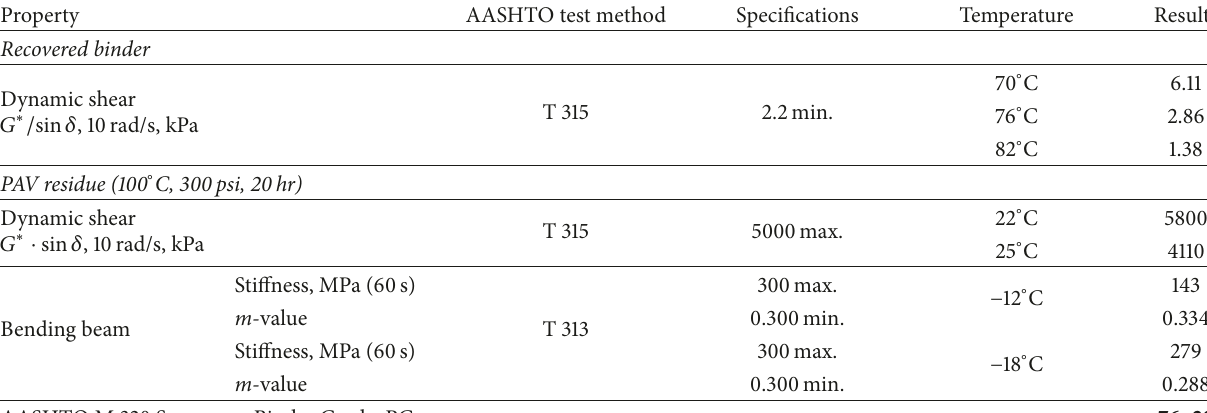
Table 1: Performance grade of the recovered binder.